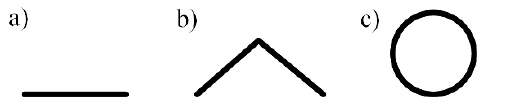
Figure 5. Structure elements of different shapes. ( a ) line shape; ( b ) triangular shape; and ( c ) circular shape.